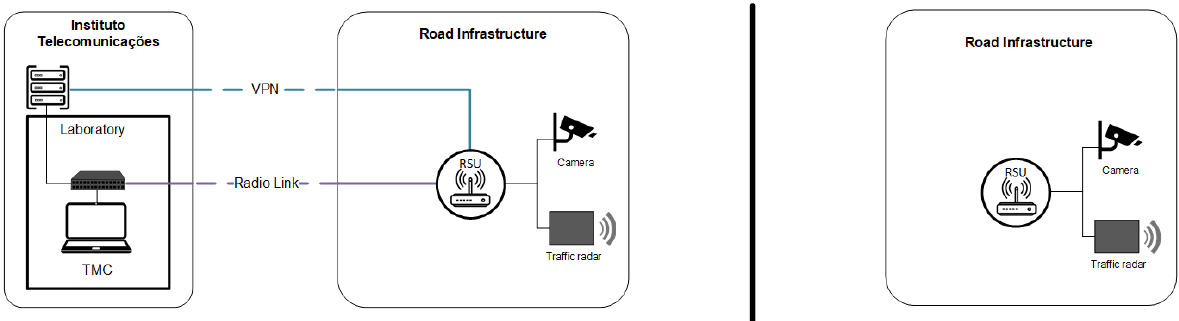
Figure 9. Possible RSU + traffic radar configurations (TMC connection on the left , Standalone mode on the right